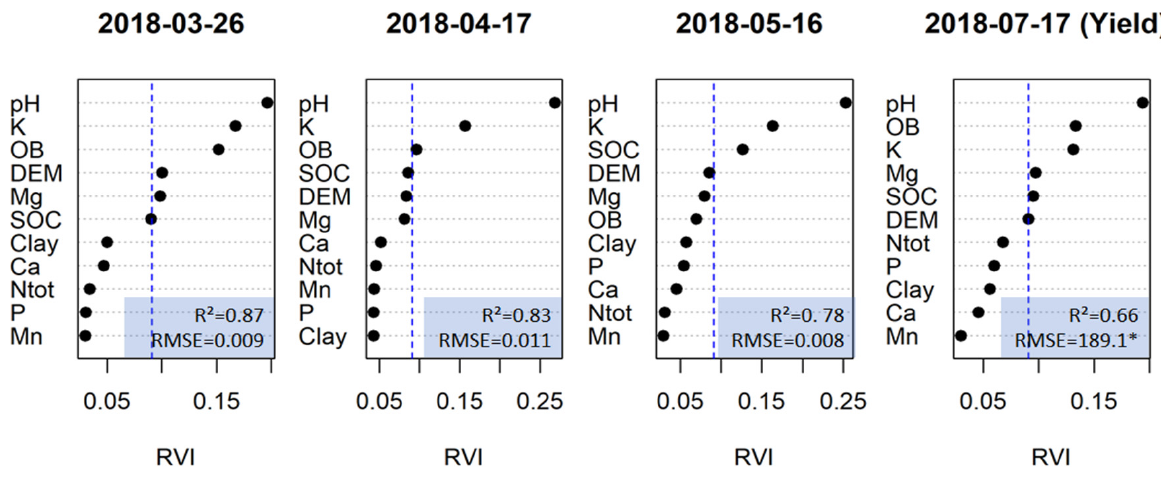
Figure 9. Relative variable importance (RVI) of predictor variables (variable importance of a given variable normalized to the sum of variable importance of all variables in the model) influential to crop growth and yields at four dates, during the growing season of winter wheat crop in 2018 over the study area (see Figure 1), calculated by CI-forest algorithm after the removal of correlated variables. The vertical dashed line indicates the expected importance in a completely random model. The performance of the models was evaluated using the R 2 and the RMSE throughout the growing season and the harvest. * Expressed in kg ha − 1 . OB stands for old borders, of the former field layout into four parcels.